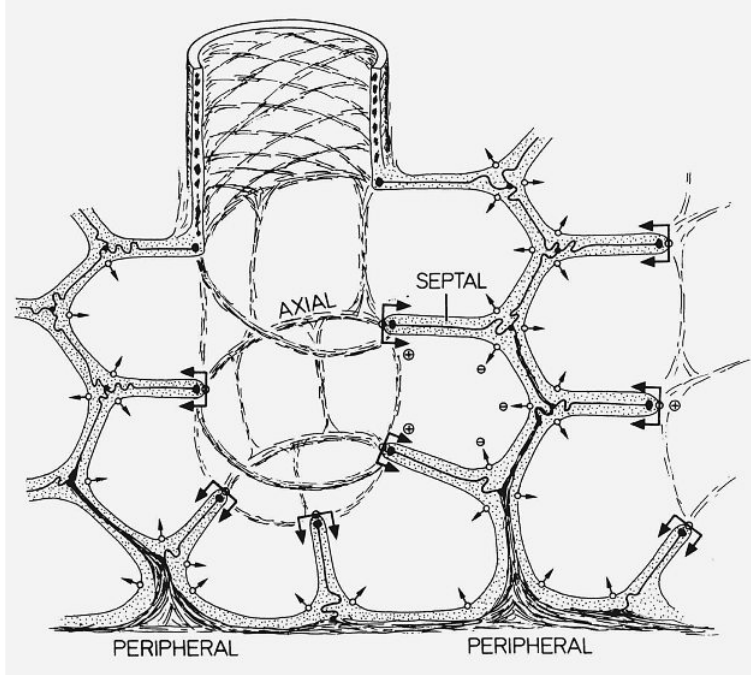
The relation between axial, septal and peripheral fibers in an alveolar duct and their relation to the surface forces acting on the alveolar complex, marked by arrows; these tend to shrink alveoli and to push on the free edge of the alveolar septa at the alveolar duct, which is supported by a strong fibre bundle of the axial network (see fig. 17B).